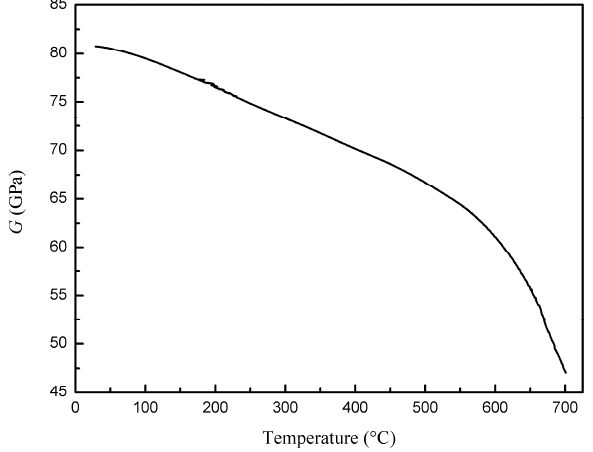
Figure 7. Shear modulus G vs. temperature determined from Mechanical Spectroscopy (MS) tests.